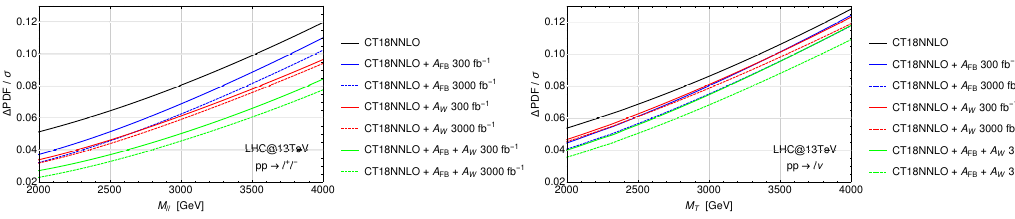
Figure 4: Relative PDF error on the invariant mass spectrum of the neutral DY channel (left) and on the transverse mass spectrum of the charged DY channel